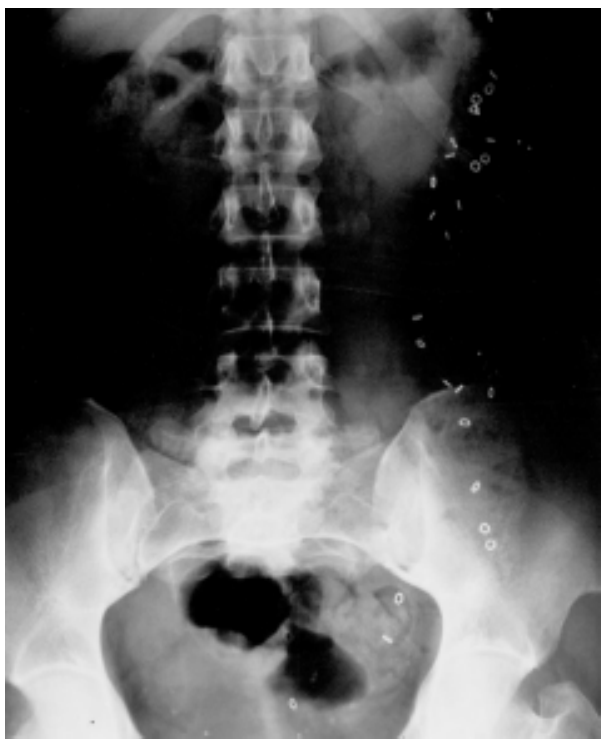
Figure 3 - Hindgut dysfunction in a patient with idiopathic constipation (IC). An abdominal X-ray taken on day 7 shows stasis of radiopaque markers in the left